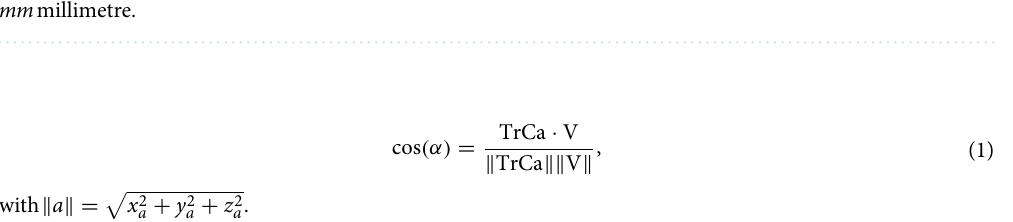
Table 1. Overview of the determination of spinal angles of the biomechanical model. °, degrees; mm